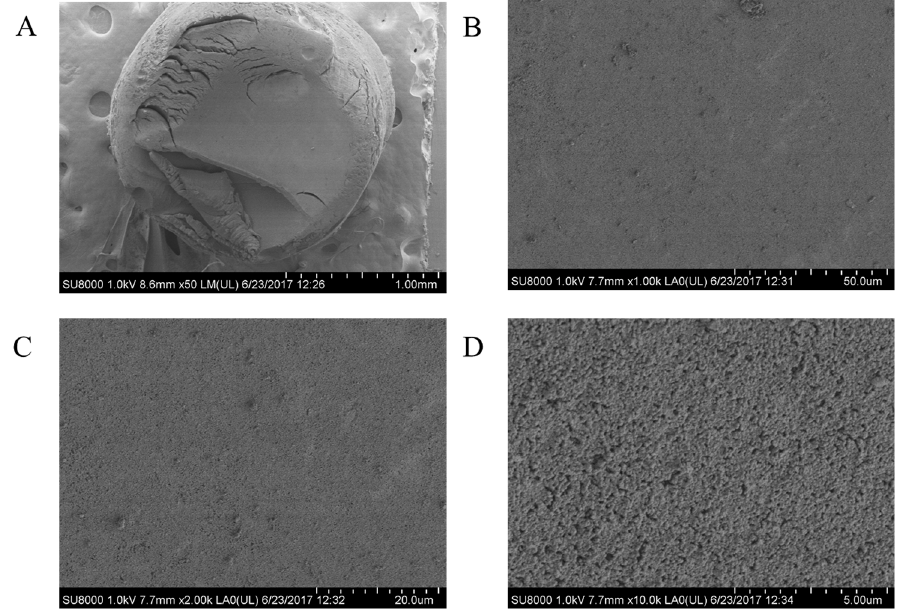
Figure 4. SEM images of the CsE aerogels ( A ) 50×; ( B ) 1000×; ( C ) 2000×; and, ( D ) 10,000× magnification.